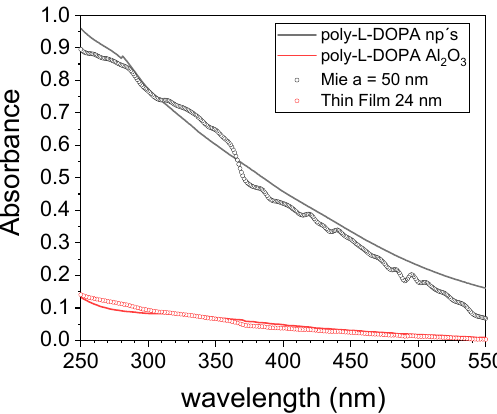
Figure 8. Absorbance spectra (line) and simulated spectra (empty circles) of the poly-L-DOPA film (red) and the aggregates of poly-L-DOPA aggregates in water (black).